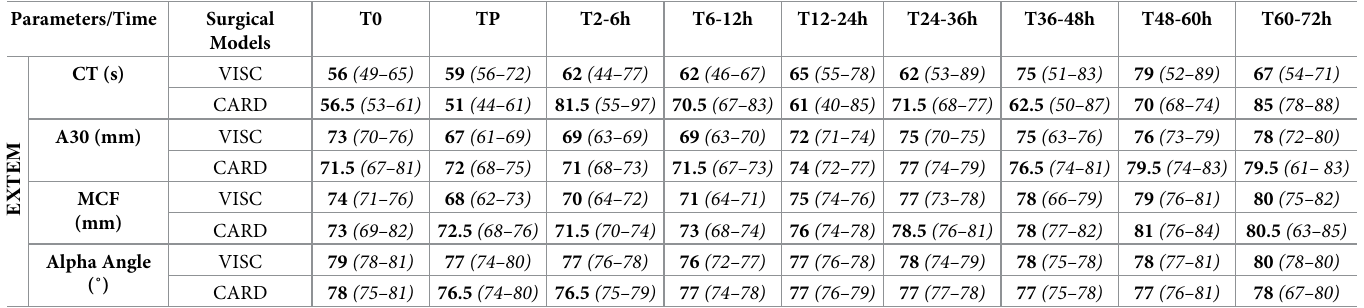
Table 1. ROTEM-EXTEM parameters during anesthesia and the 72 h survival follow-up period (9 sampling times).